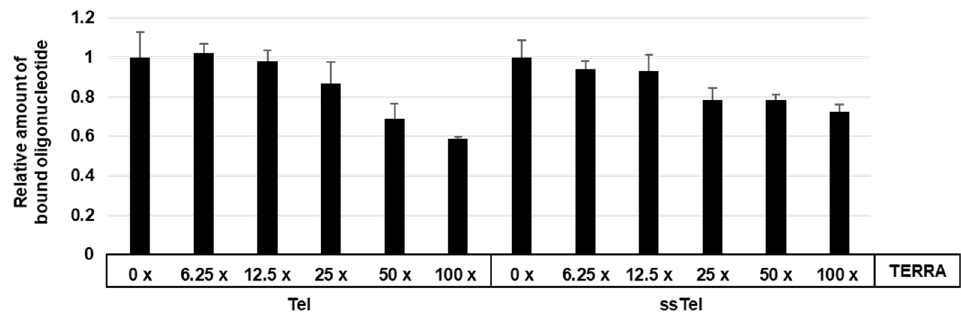
Figure 4. Flag-hnRNP U 683C fusion proteins made in E. coli were IP:d with anti-Flag agarose gel. IPs were mixed with Tel or ssTel oligonucleotides, followed by adding indicated-fold amount of TERRA oligonucleotides. After washing the beads, bound oligonucleotides were purified and pulled down by streptavidin magnetic beads. After washing the beads, adapter oligonucleotide (Tel linker) was mixed and bound adapter oligonucleotide was detected by qPCR. See Supplemental standard curve, Figure A.